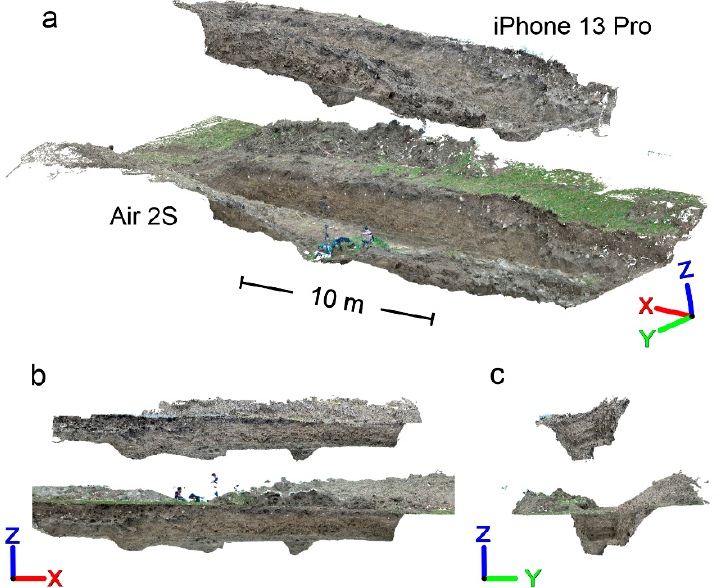
Figure 2. Visual comparison in CloudCompare of the Air 2S model with the iPhone model, using oblique ( a ) north ( b ) and east ( c ) oriented views.